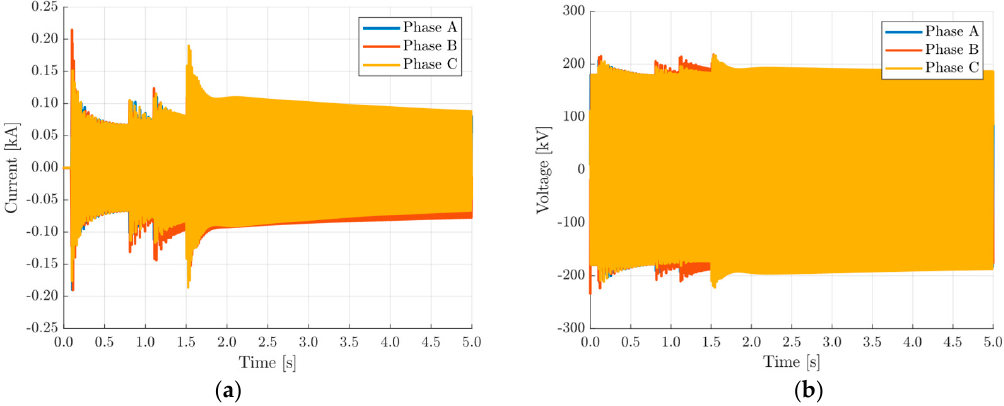
Figure 4. Current ( a ) and voltage ( b ) waveforms with synchronous generator as self-start unit in the simplified benchmark system.